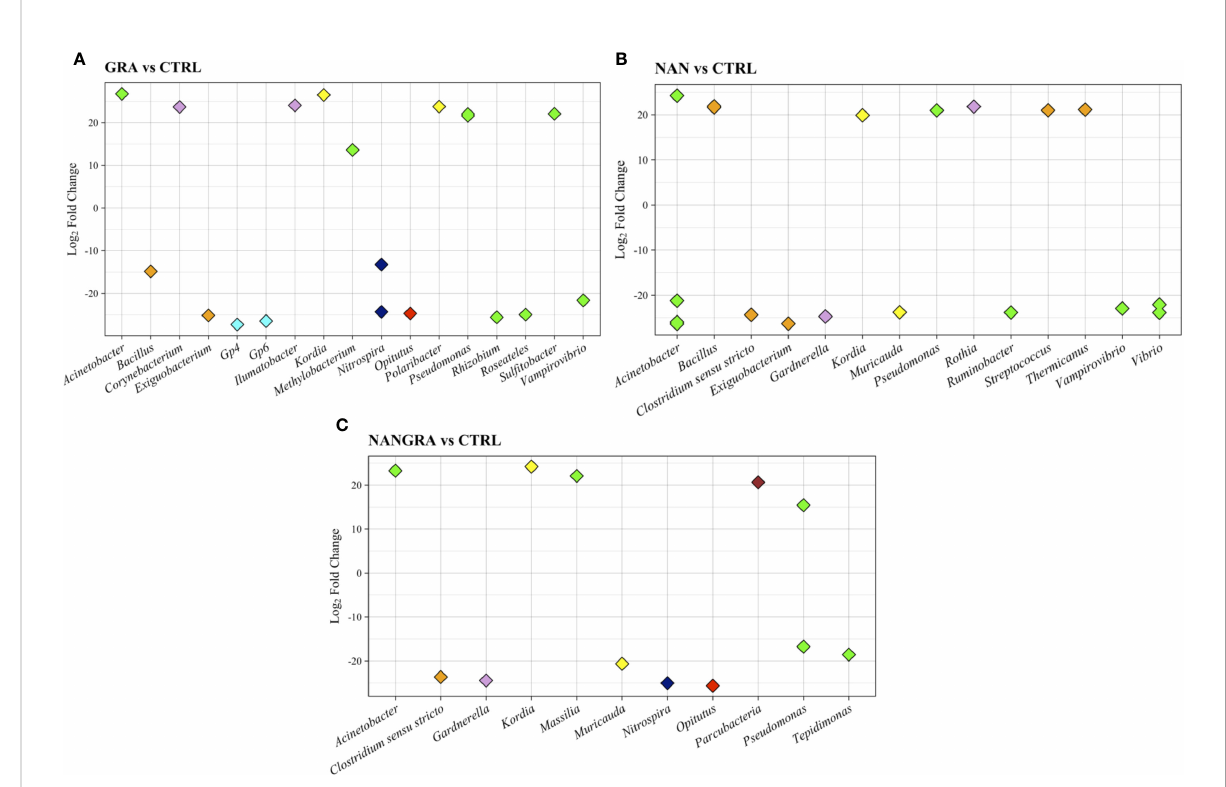
FIGURE 5 Differently abundant genera in the study groups. (A) GRA group vs CTRL group. (B) NAN group vs CTRL group. (C) NANGRA group vs CTRL group. Color codes: green – Proteobacteria ( Acinetobacter , Methylobacterium , Pseudomonas , Rhizobium , Roseateles , Sul fi tobacter , Vampirovibrio , Ruminobacter , Vibrio , Massilia and Tepidimonas ); orange – Firmicutes ( Bacillus , Exiguobacterium , Clostridium sensu stricto ); pink – Actinobacteria ( Corynebacterium , Ilumatobacter , Gardnerella and Rothia ); light blue – Acidobacteria ( Gp4 and Gp6 ); yellow – Bacteroidetes ( Kordia and Muricauda ); dark blue – Nitrospirae ( Nitrospira ); light red – Verrucomicrobia ( Opitutus ); dark red – Parcubacteria